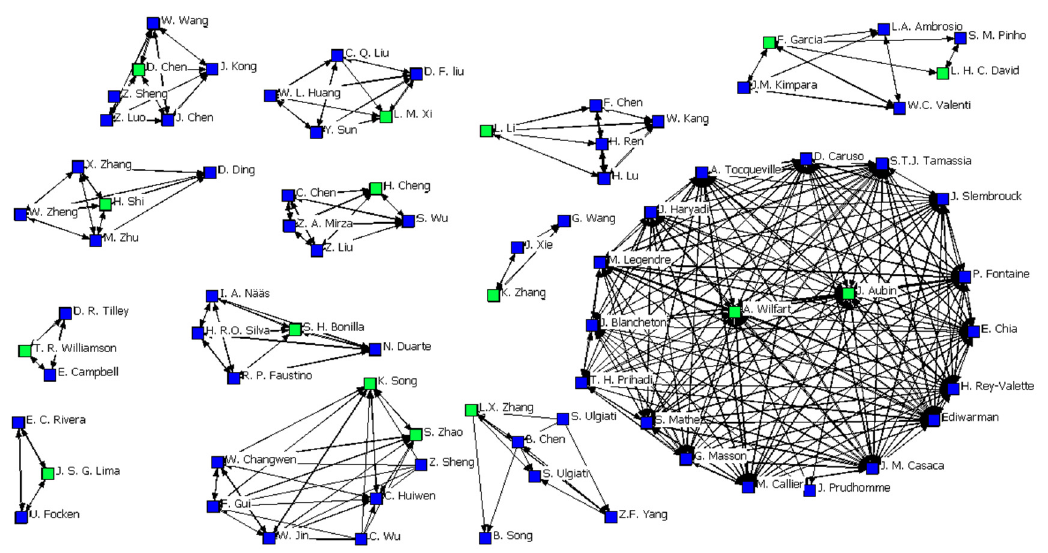
Figure 5. Network of authors and co-authors of articles included in the research. Source: Prepared by the author at Ucinet.